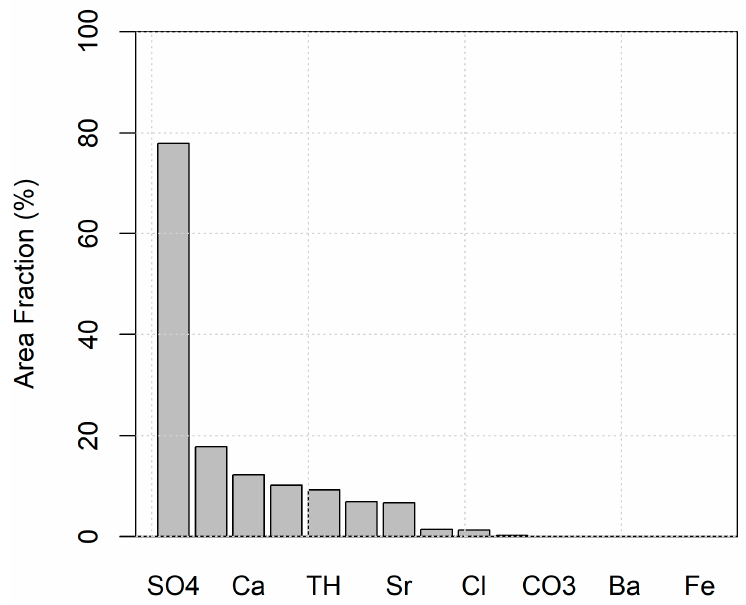
Figure 6. Fraction of incompatibility per constituent of concern for gel-based hydraulic fracturing water use.